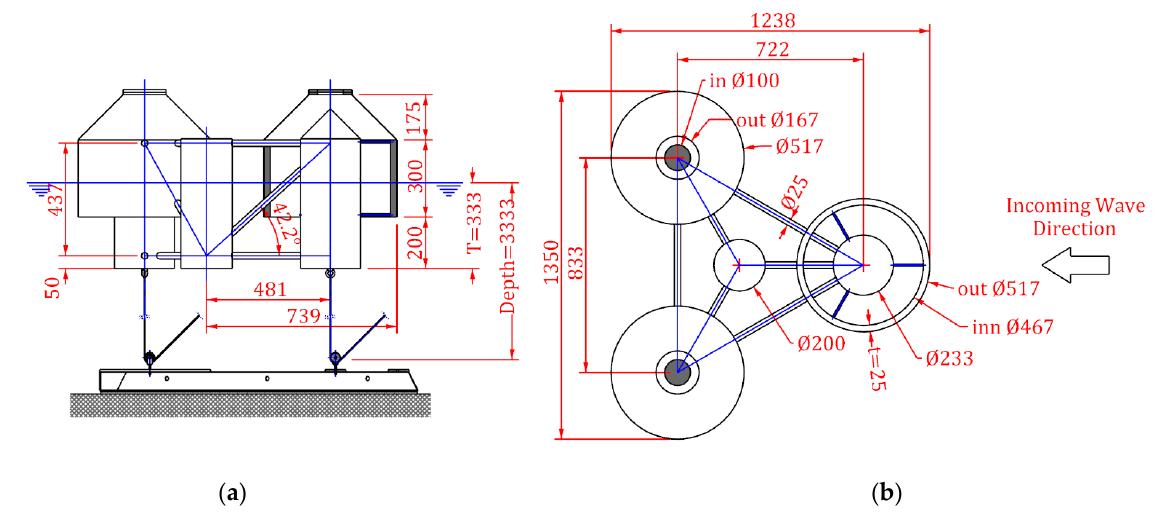
Figure 6. Two-dimensional (2-D) general views of the REFOS 1/60 model: ( a ) side view, ( b ) top view. All dimensions in mm.